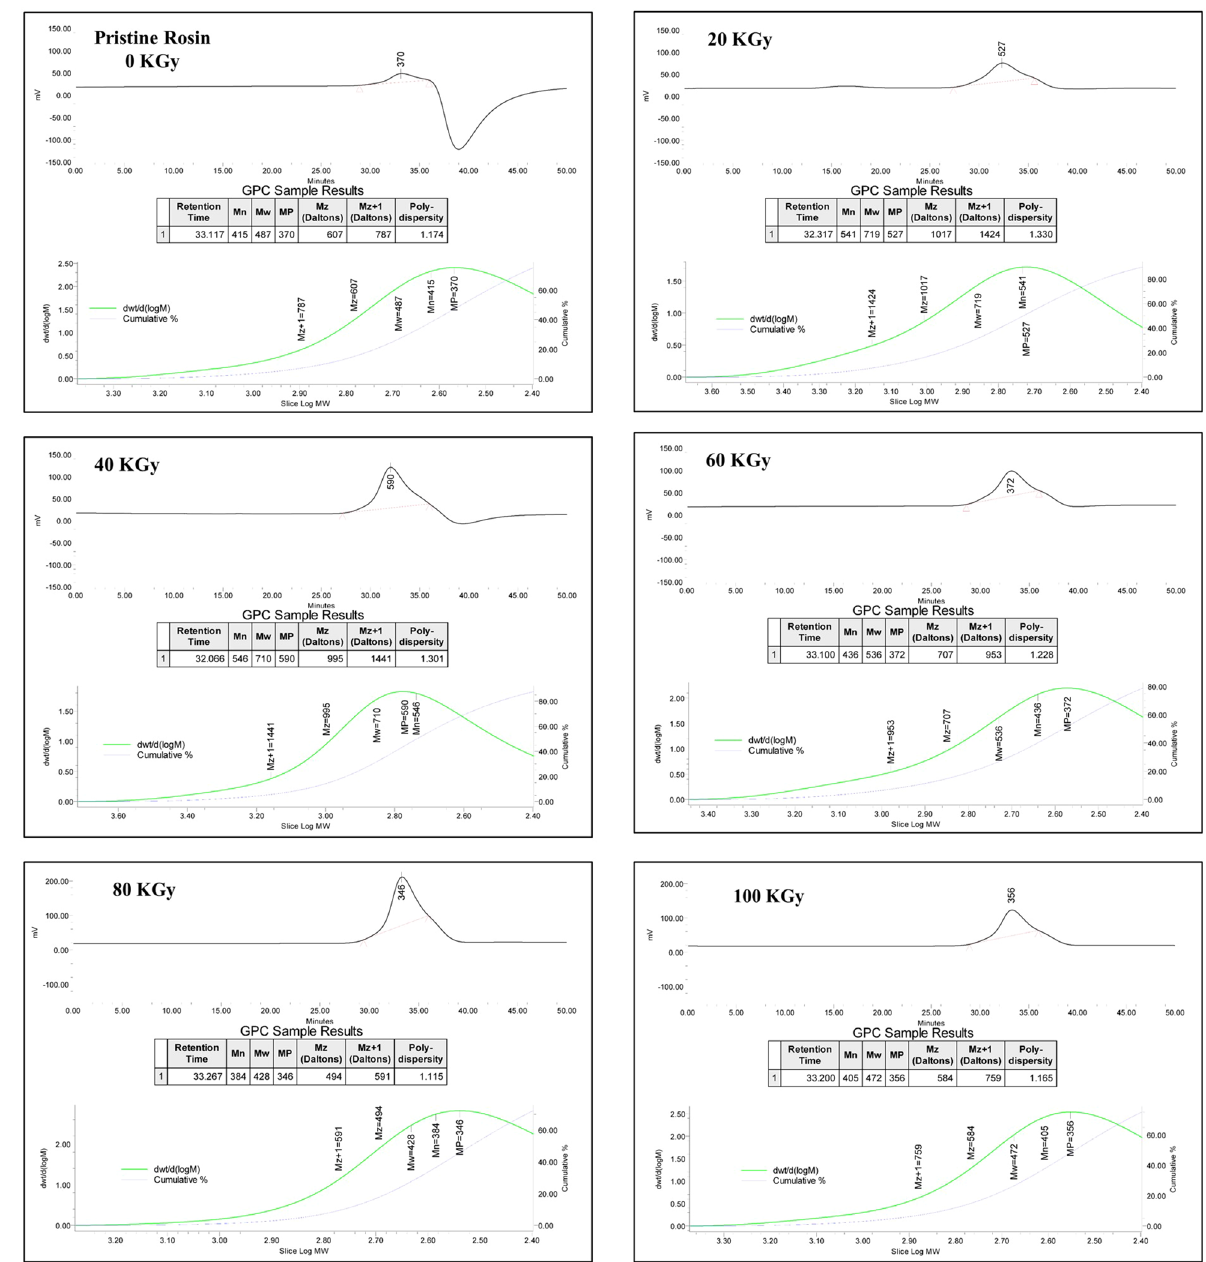
Figure 3. GPC charts and information of R-0, R-20, R-40, R-60, R-80, and R-100